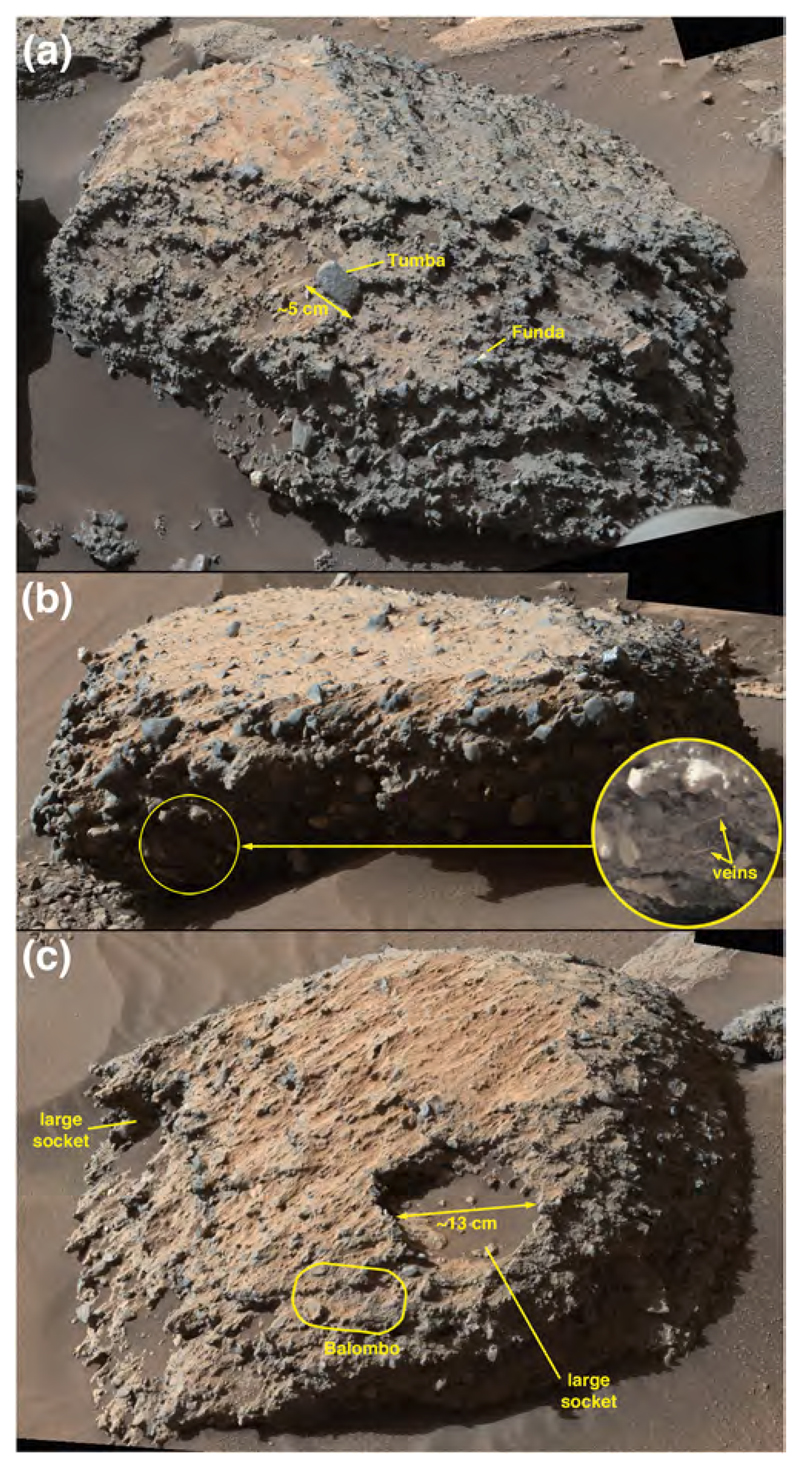
(a) Conglomeratic boulder containing MAHLI targets Tumba and Funda; the latter was also an APXS target. (b) Conglomeratic boulder, ~60 cm wide, that includes veins that cut across the sandy matrix (inset). (c) Conglomeratic boulder that includes the ChemCam target Balombo (outline indicates RMI image coverage).